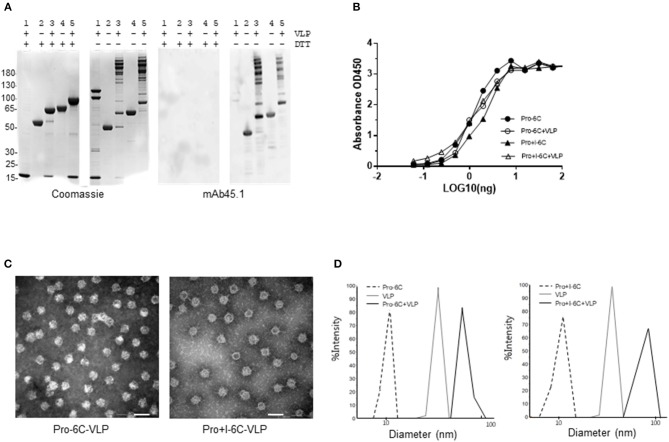
Characterization of virus-like particle-based vaccines. SpyCatcher tagged Pro-6C and Pro+I-6C were mixed with SpyTag-AP205 resulting in a unidirectional display of the chimeras on the VLP surface. (A) Reduced and non-reduced SDS-PAGE gel and western blot. The gels (left) are stained with coomassie blue, while the western blots (right) are developed with mAb45.1 as primary antibody. The following was loaded corresponding to the numbers; Lane 1: AP205 (VLP); lane 2: Pro-6C; lane 3: Pro-6C-VLP; lane 4: Pro+I-6C; Lane 5: Pro+I-6C-VLP. (B) Sandwich ELISA, using mAb 45.1 as the solid phase capture antibody. (C) Transmission electron microscopy images (negative stain) of the VLP-based vaccines after assembly. Both Pro-6C-VLPs and Pro+I-6C-VLPs appear non-aggregated, uniformly dispersed and have an estimated size of 30 nm. Scale bar 100 nm. (D) Dynamic light scattering (DLS) profile of the vaccine components Pro-6C [10.5 nm, polydispersity (PD) 10.7%], Pro+I-6C (10.8 nm, PD 20.7%), VLP (25.6 nm, PD 16.8%) and the purified vaccine products; Pro-6C-VLP (71.8 nm, PD 11.5%), and Pro+I-6C-VLP (73.7 nm, PD 15.8%).